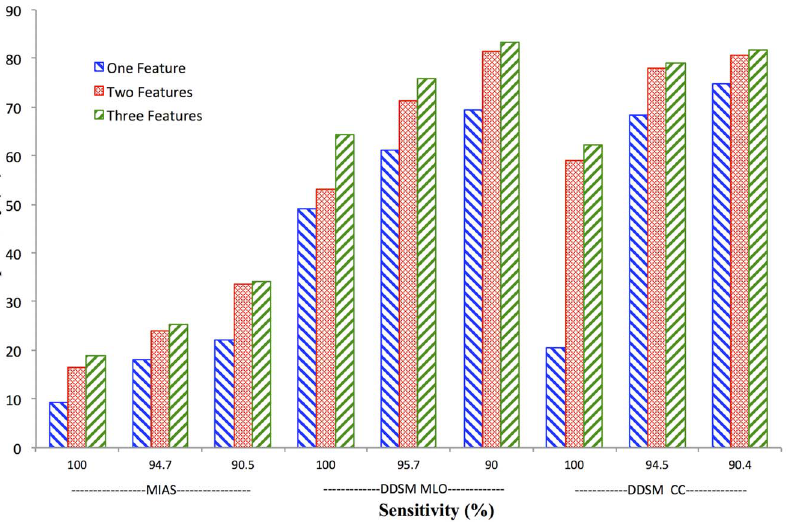
Figure 4. Effect of feature vector size on Bayesian classifier performance. Specificity versus sensitivity for all datasets. One (light grey), two (medium grey) or three (dark grey) feature combinations were tested at three sensitivity levels.